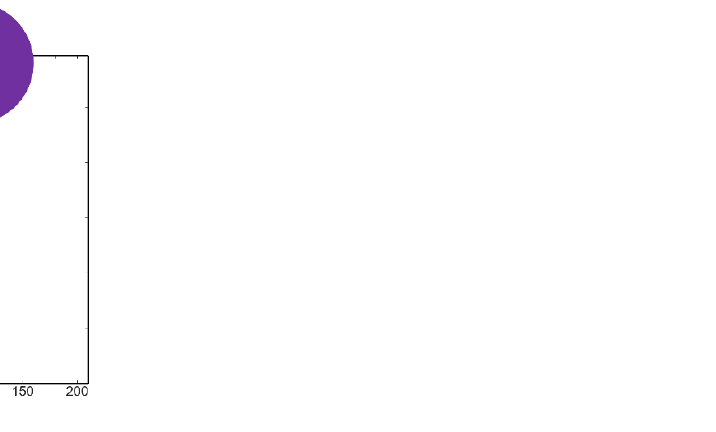
Figure 9. Landing spots on the A4-paper-sized platform; the black circle represents the reference landing position, and the red crosses are the actual landing spots. Table 2. MAV landing spot statistics. Ten trials were conducted in every direction.